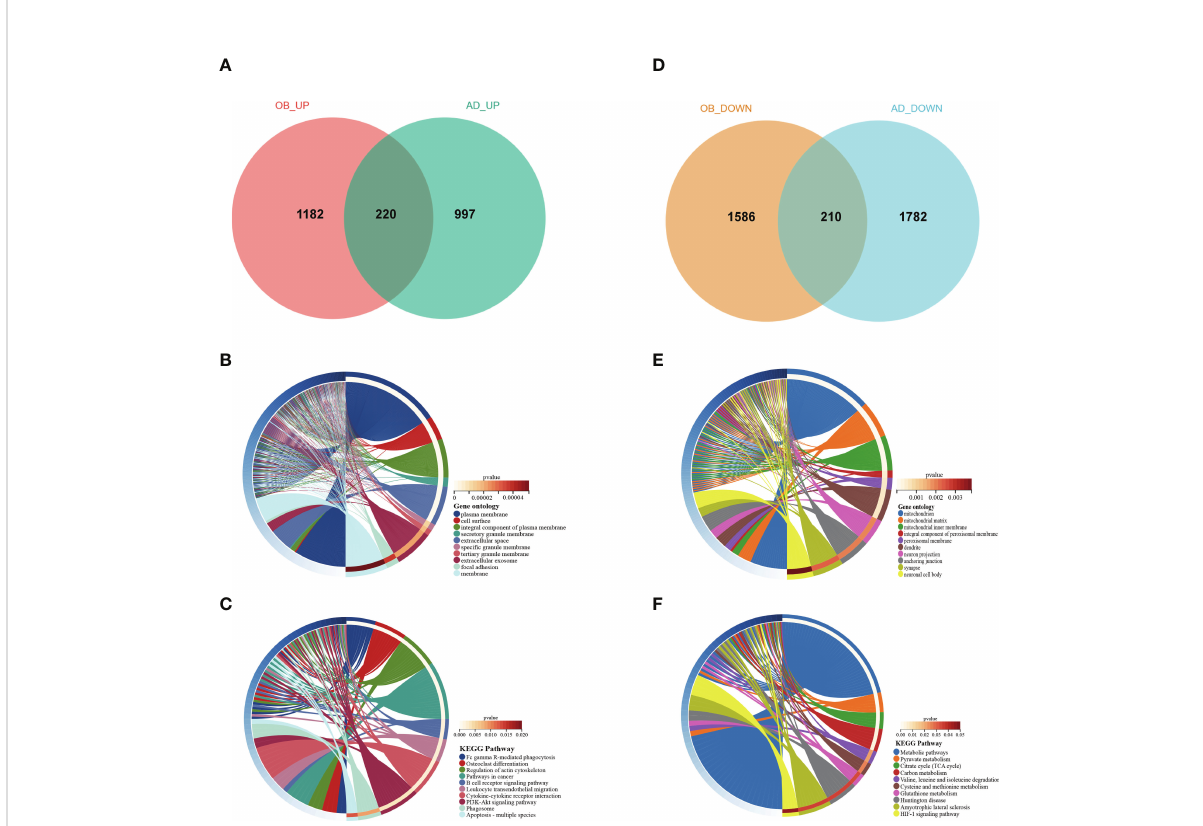
FIGURE 5 Venn diagram and enrichment analysis of the common DEGs. (A) The Venn diagram of the upregulated genes in GSE44000 and GSE122063. (B) The GO biological process analyses of common-upregulated genes. (C) The KEGG pathway of common-upregulated genes. (D) The Venn diagram of the downregulated genes in GSE44000 and GSE122063. (E) The GO biological process analyses of common-downregulated genes. (F) The KEGG pathway of common-downregulated genes. GO, gene ontology; DEGs, differentially expressed